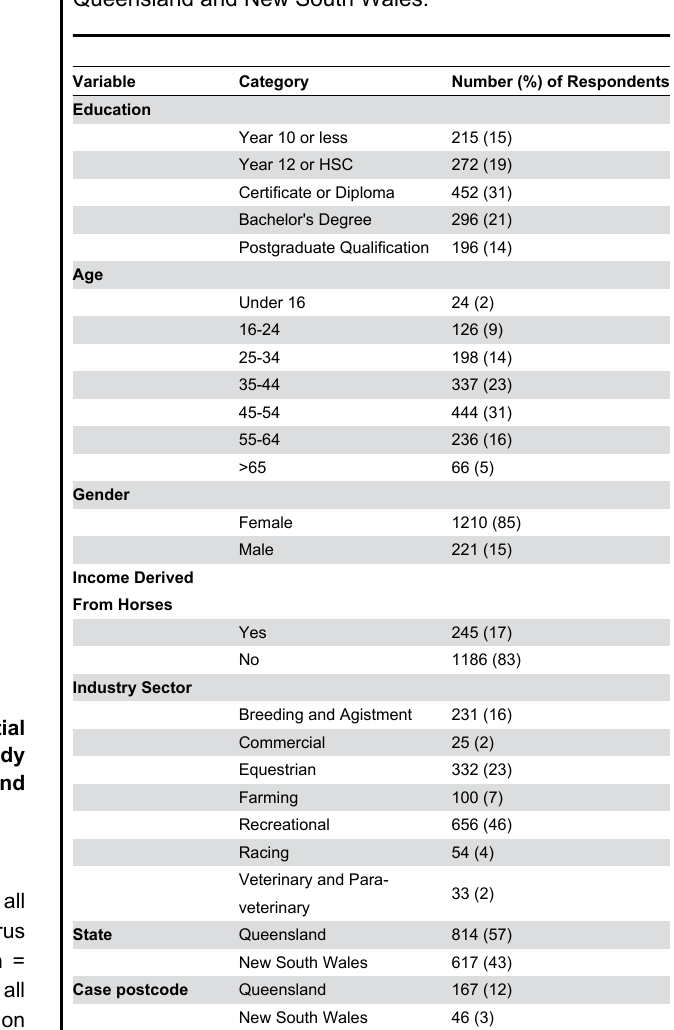
Table 1. Demographic characteristics of the